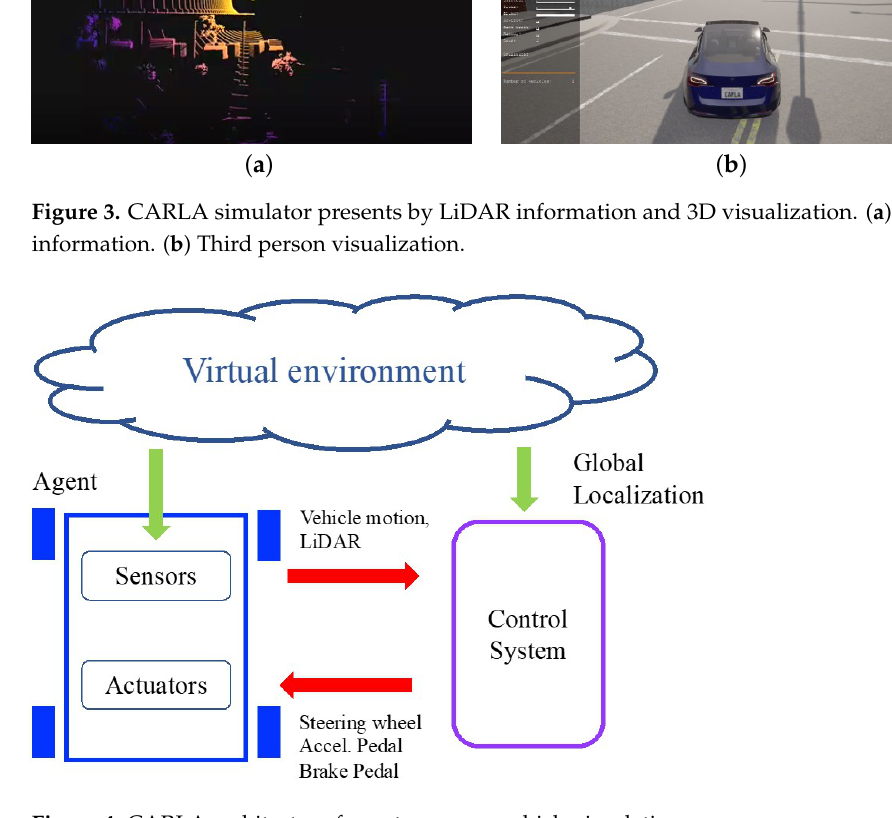
Figure 4. CARLA architecture for autonomous vehicle